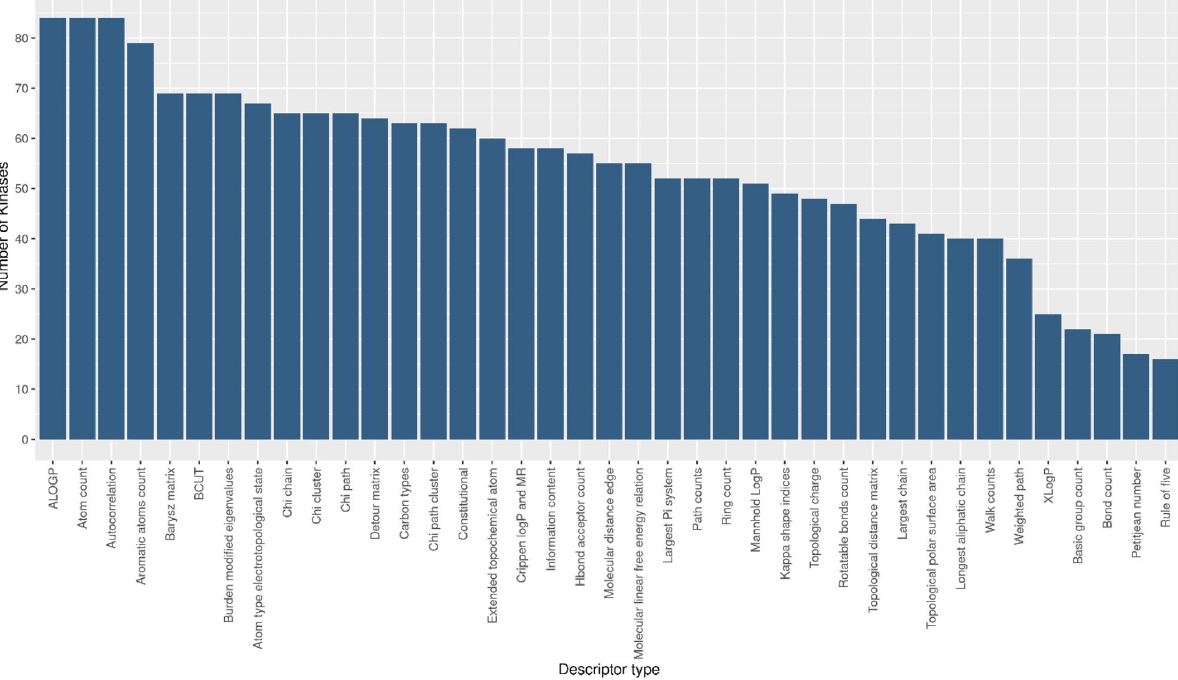
Figure 4. Most frequent descriptors type. The most frequent descriptors emerged from feature selection used to train the BMF1 models related to the 84UKs used in the